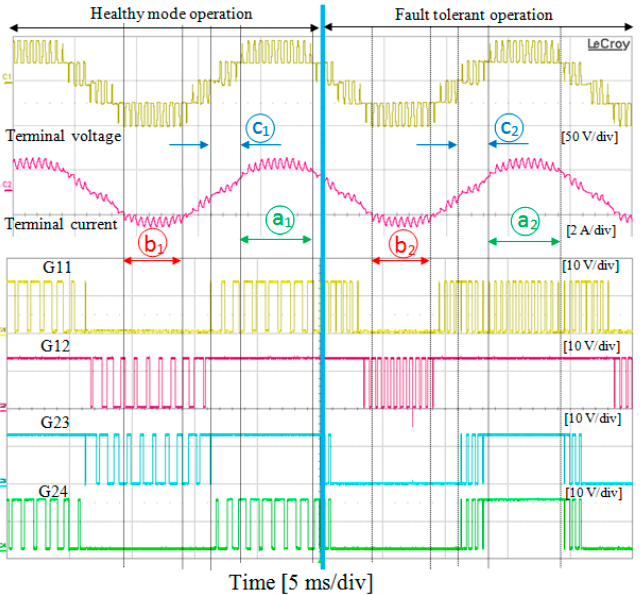
Figure 12. Detailed experimental results of the fault-tolerant strategy in case of fault event in D c4 .